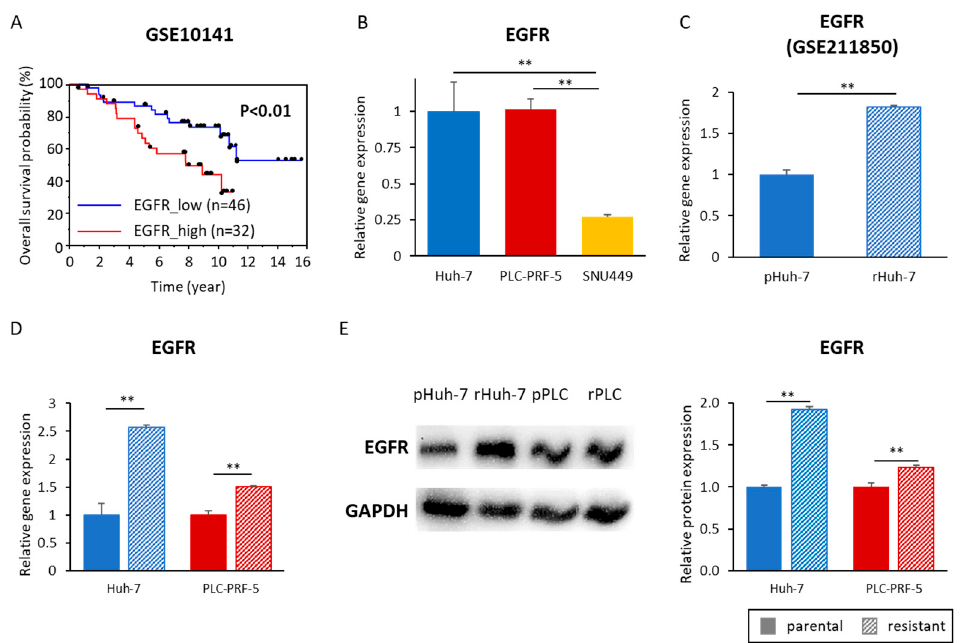
Figure 5. EGFR activation was associated with the poor prognosis in HCC patients and acquired resistance. ( A ) Survival curves of high and low expression of EGFR among patients with HCC. ( B ) EGFR gene expression in Huh ‐ 7, PLC ‐ PRF, and SNU449 cell lines (**: p < 0.01). ( C ) EGFR gene expression in